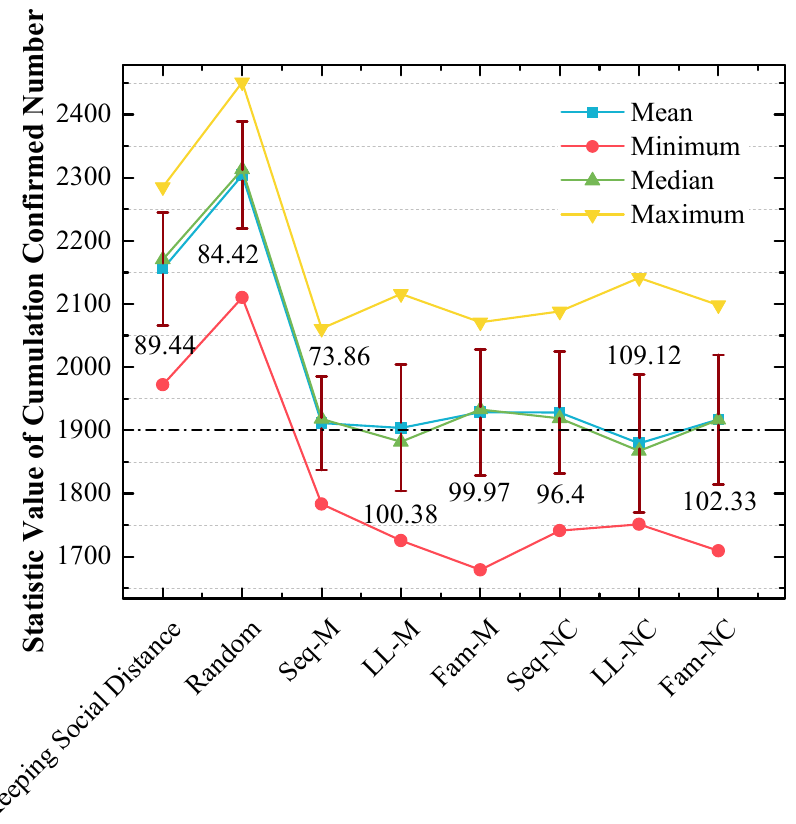
Figure 11. The cumulative frequency of cumulated confirmed numbers under different strategies in the 2nd scenario. The x ‐ value of the dash line is 1850.